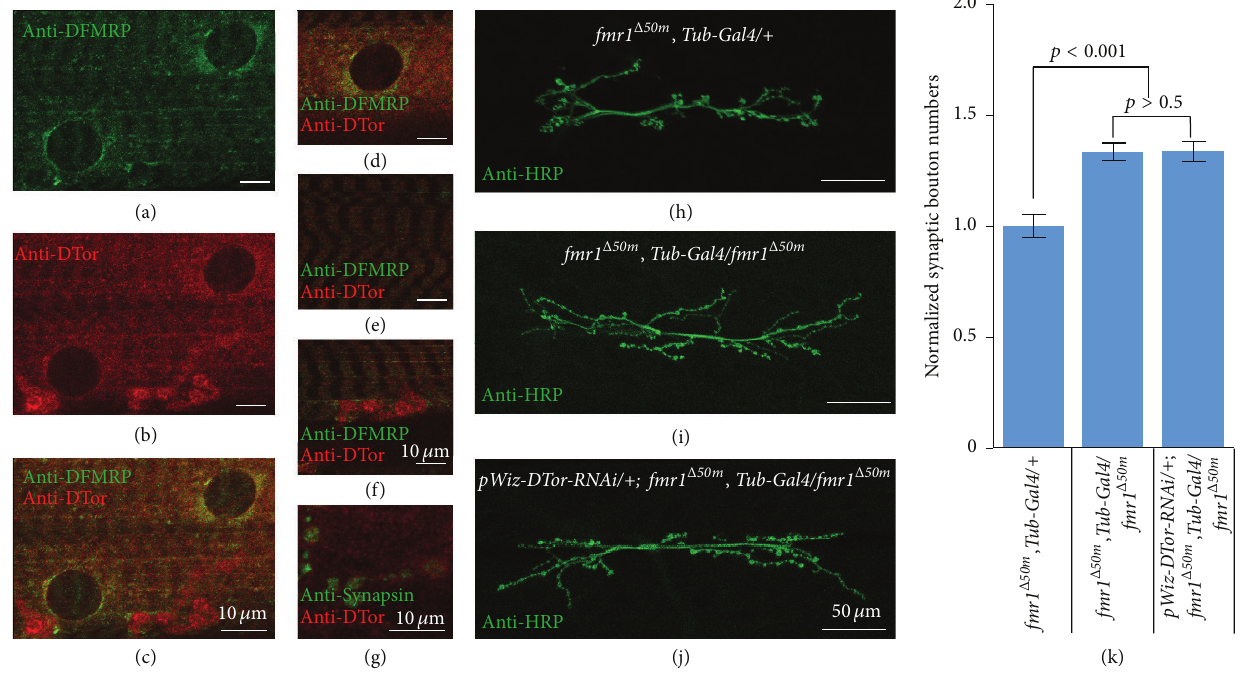
Figure 9: Colocalization and genetic interaction between DTor and DFMRP in Drosophila . (a–c) Localization patterns of DTor (red) and DFMRP (green) in w1118 larval muscles. DTor and DFMRP proteins are partially colocalized in muscle organelles. They are partially colocalized at (d) the outside of nuclear membranes in muscles and (e) muscle fibers. However, they are not colocalized at synaptic boutons (f). (g) A small portion of DTor protein at the synaptic boutons was colocalized with Synapsin. (h–j) Representative NMJ morphology of genetic background larvae ( fmr1 Δ 50m , Tub-Gal4 /+), dfmrp mutant larvae ( fmr1 Δ 50m , Tub-Gal4 / fmr1 Δ 50m ), and dfmrp mutant larvae expressing DTor-RNAi ( pWiz-DTor-RNAi/+; fmr1 Δ 50m Tub-Gal4 / fmr1 Δ 50m ). (k) The quantification of the normalized number of synaptic boutons from three mutant